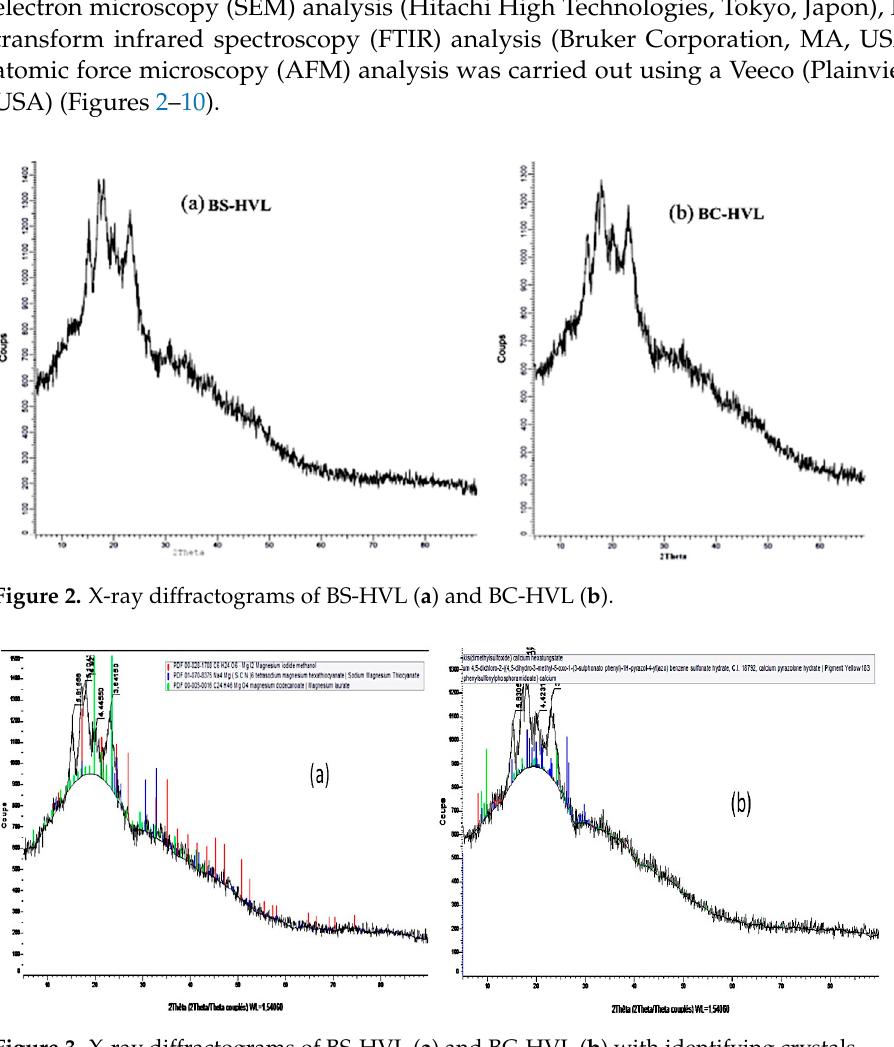
Figure 3. X-ray diffractograms of BS-HVL ( a ) and BC-HVL ( b ) with identifying crystals.